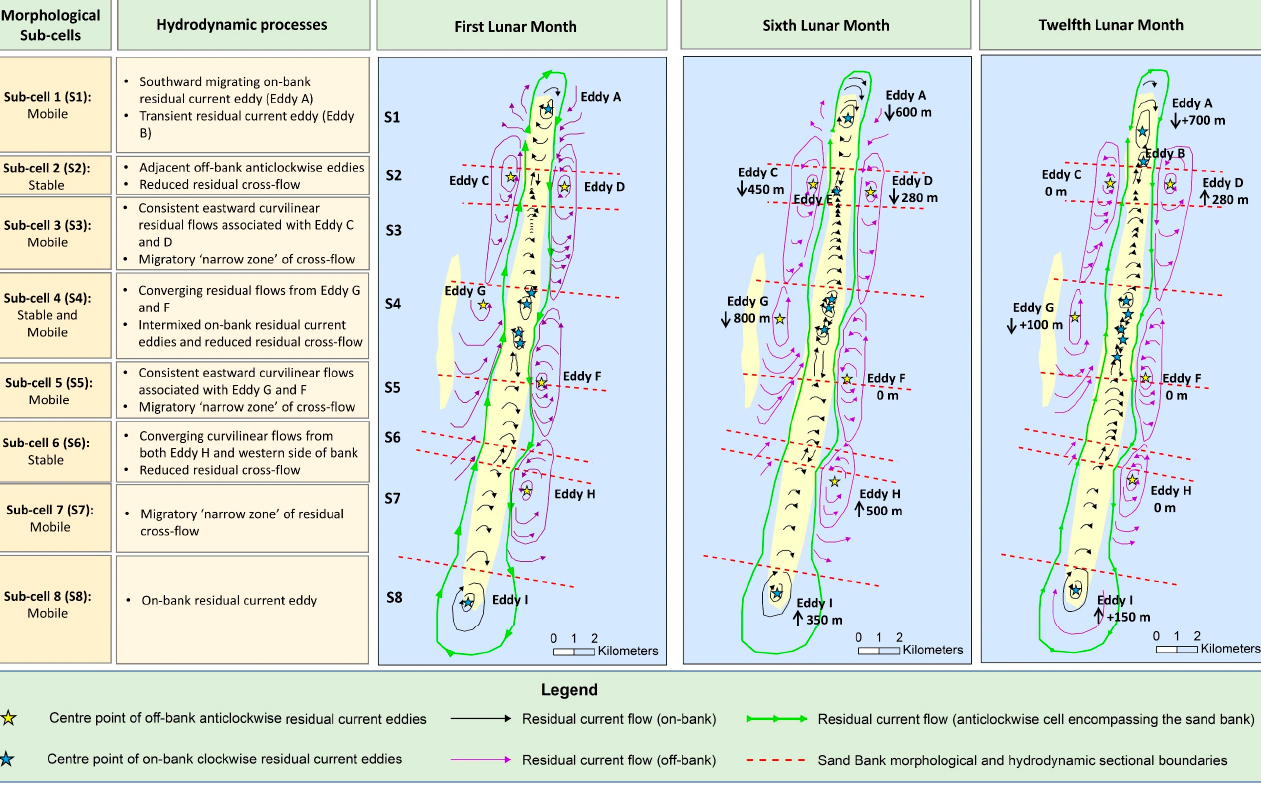
Figure 12. A schematic diagram summarising the hydrodynamic processes driving Arklow Bank’s upper slope mobility and bank base stability.